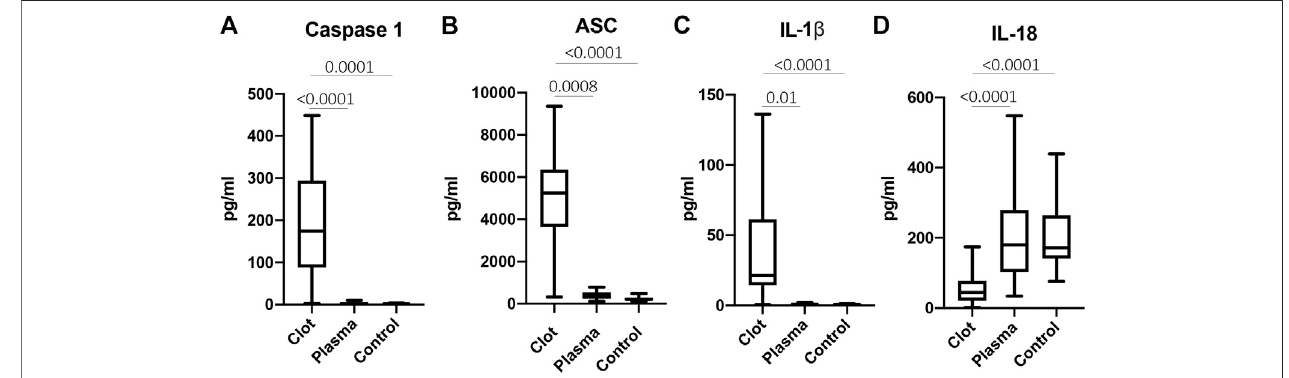
FIGURE4| In fl ammasomesignaling proteins are elevated intheclots ofpatients with stroke. Protein levelsin pg/mlofcaspase-1 (A) , ASC (B) ,IL-1 β (C) and IL-18 (D) in the clots of patients with AIS as well as plasma of stroke patients (plasma) and from healthy controls (control). Caspase-1: N (cid:1) 26 clot, N (cid:1) 13 plasma stroke patients,N (cid:1) 39plasmahealthycontrol;ASC:N (cid:1) 26clot,N (cid:1) 11plasmastrokepatients,N (cid:1) 8plasmahealthycontrol;IL-1 β :N (cid:1) 19clot,N (cid:1) 5plasmastrokepatients,N (cid:1) 15 plasma healthy control; IL-18: N (cid:1) 25 clot, N (cid:1) 15 plasma stroke patients, N (cid:1) 39 plasma healthy control a. Box and whiskers are shown for the 5th and 95th percentile. p -value of signi fi cance < 0.05. All groups were compared by a Kruskall-Wallis test followed by Dunn ’ s multiple comparison test.